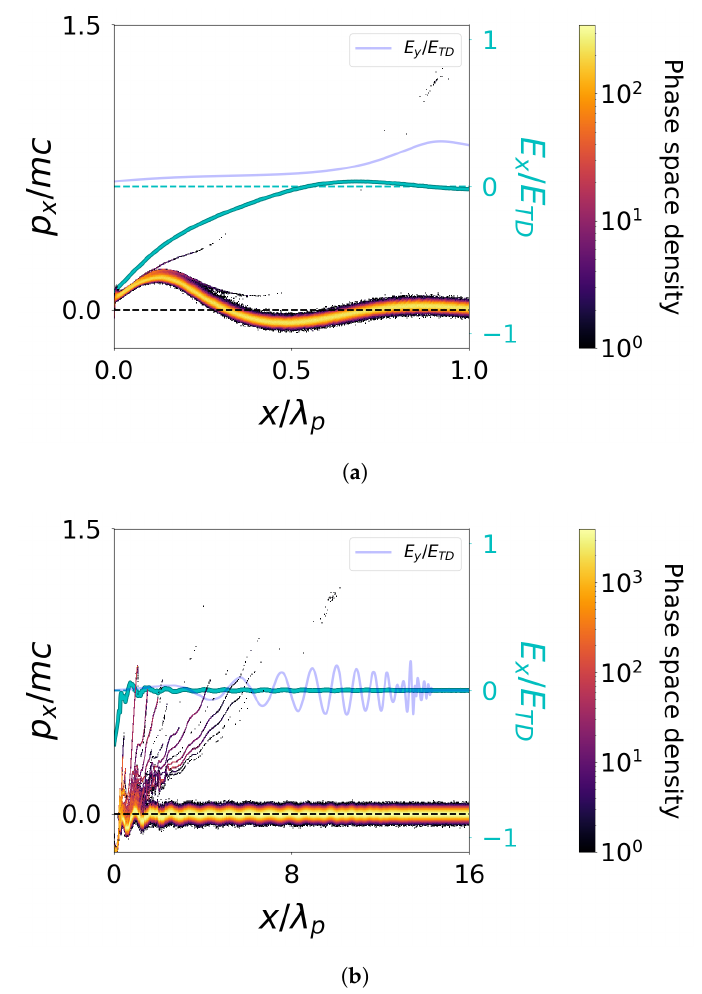
Figure 2. A snapshot of the electron phase space p x vs. x and field structure of the high-density (“black”) case n c / n e = 1 of a 1D carbon nanotube with laser intensity a 0 = 1 at early ( a ) and later ( b ) stages. The heatmap shows warmer colors for higher phase-space density. The longitudinal E x (green) and laser E y (translucent blue) fields are plotted according to the right axis. The plasma wavelength is equal to λ p = 1 micron. ( a ) is zoomed to 0 ≤ x ≤ λ p from ( b ). A similar run is made in previous work